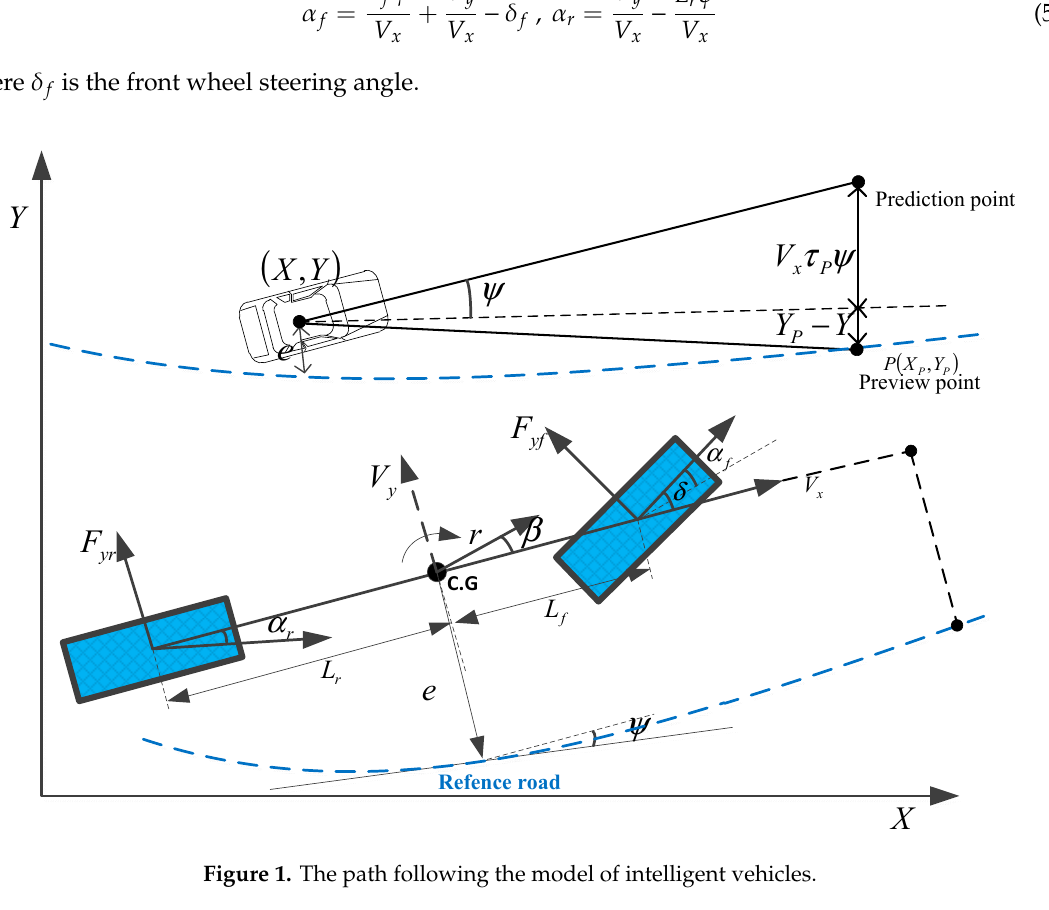
Figure 1. The path following the model of intelligent vehicles.